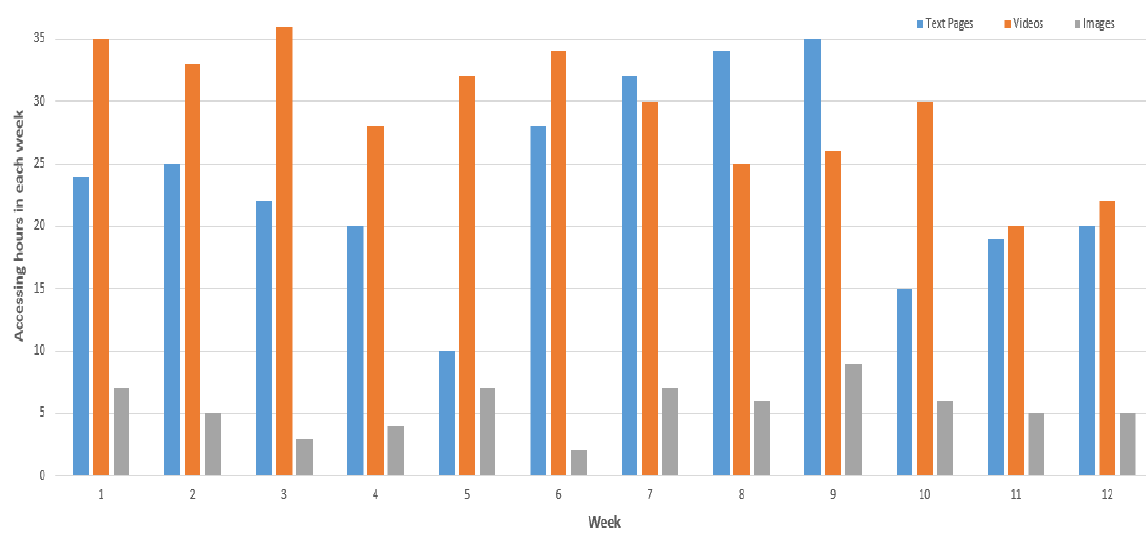
Figure 5. On average, the learners spent 23.67 h accessing the textual information, 29.25 h accessing the video resources, and 5.5 h accessing the images.